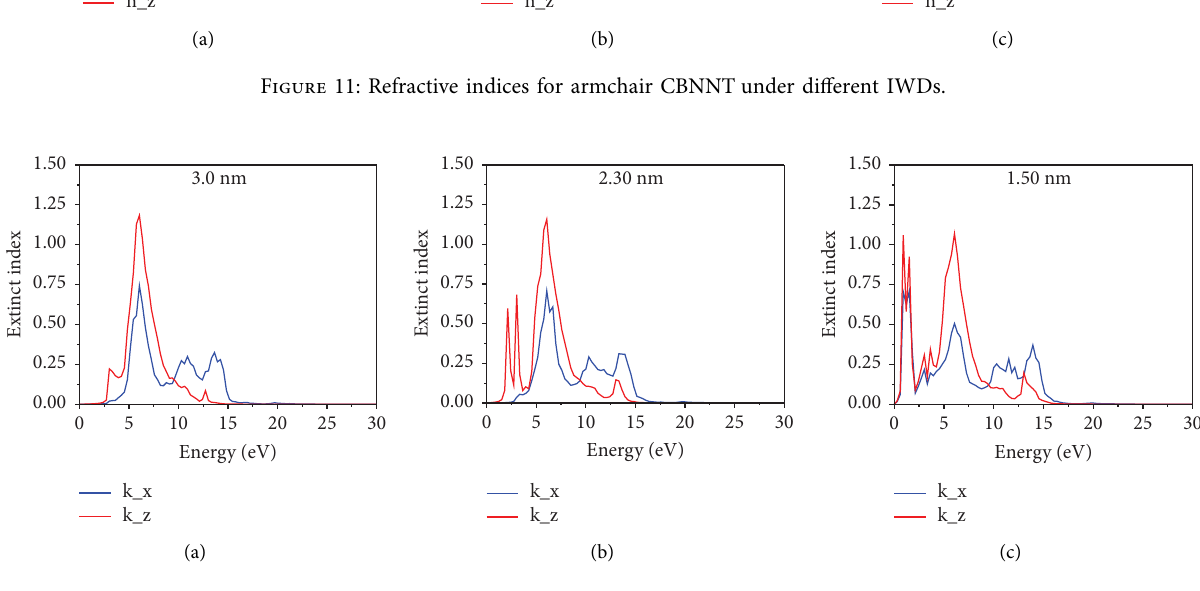
Figure 12: Extinct indices for armchair CBNNT under diferent IWDs.